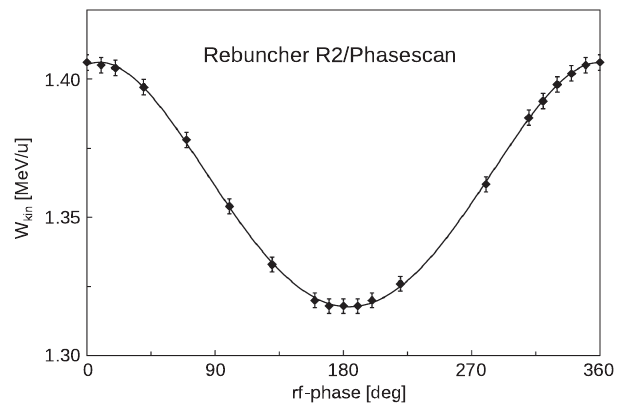
FIG. 6. Ar 9 þ -rf phase scan with rebuncher R2; nominal beam energy (HLI exit) is measured for 1 . 366 MeV/u.